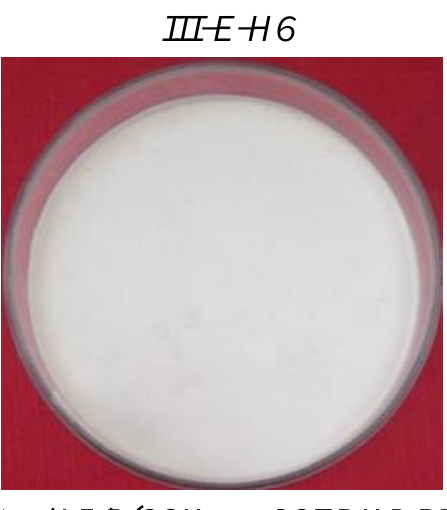
Figure 5. Photographs of the film PVAc/H5/P(SSH-co-SSTBHDPB80).